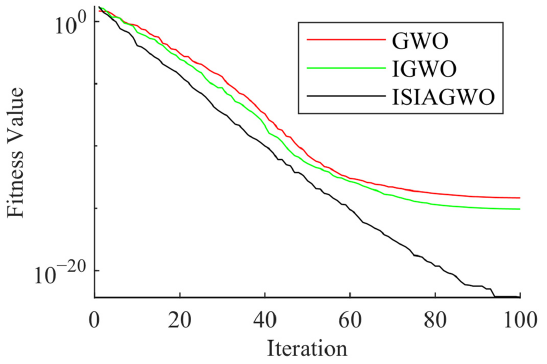
Figure 4. Schwefel’s Problem 2.22 Functional optimization curves.